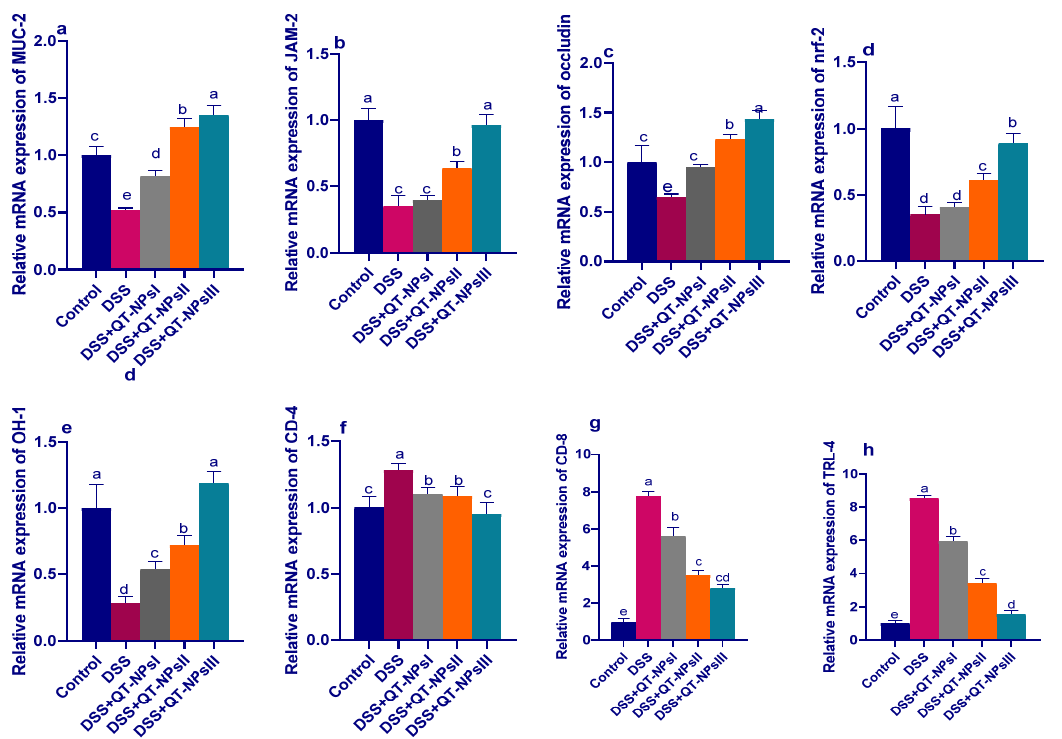
Figure 7. Impacts of quercetin-loaded nanoparticles (QT-NPs) therapy on mRNA expression of tight junction-related genes mucin-2 (MUC-2) ( a ), junction adhesion molecule (JAM) ( b ), occludin ( c ), nuclear factor erythroid 2-related factor 2 (NRF2)-Kelch-like erythroid cell-derived protein ( d ), heme oxygenase-1 (Hmox1, HO-1) ( e ), gene encoding the CD4 membrane glycoprotein of T lymphocytes ( f ), gene encoding the CD8 membrane glycoprotein of T lymphocytes ( g ), toll-like receptor-4 (TLR-4) ( h ) 14 days post DSS induction. Mean values with different letters in the same row differ significantly at p < 0.05, SE: standard error. a–e Means of the rows with different letters were significantly different among groups ( p < 0.05). Control: healthy non-colitic group (rats orally gavaged with PBS); colitic groups: DSS (rats orally gavaged with dextran sodium sulphate), DSS + QT-NPsI (rats orally gavaged with DSS and quercetin-loaded nanoparticles (QT-NPs at the level 10 mg/kg body weight for 14 days)), DSS + QT-NPsII (rats orally gavaged with DSS and quercetin-loaded nanoparticles (QT-NPs at the level 15 mg/kg body weight for 14 days)), and DSS + QT-NPsIII (rats orally gavaged with DSS and quercetin-loaded nanoparticles (QT-NPs at the level 20 mg/kg body weight for 14 days)). All groups orally gavaged by 3% DSS.